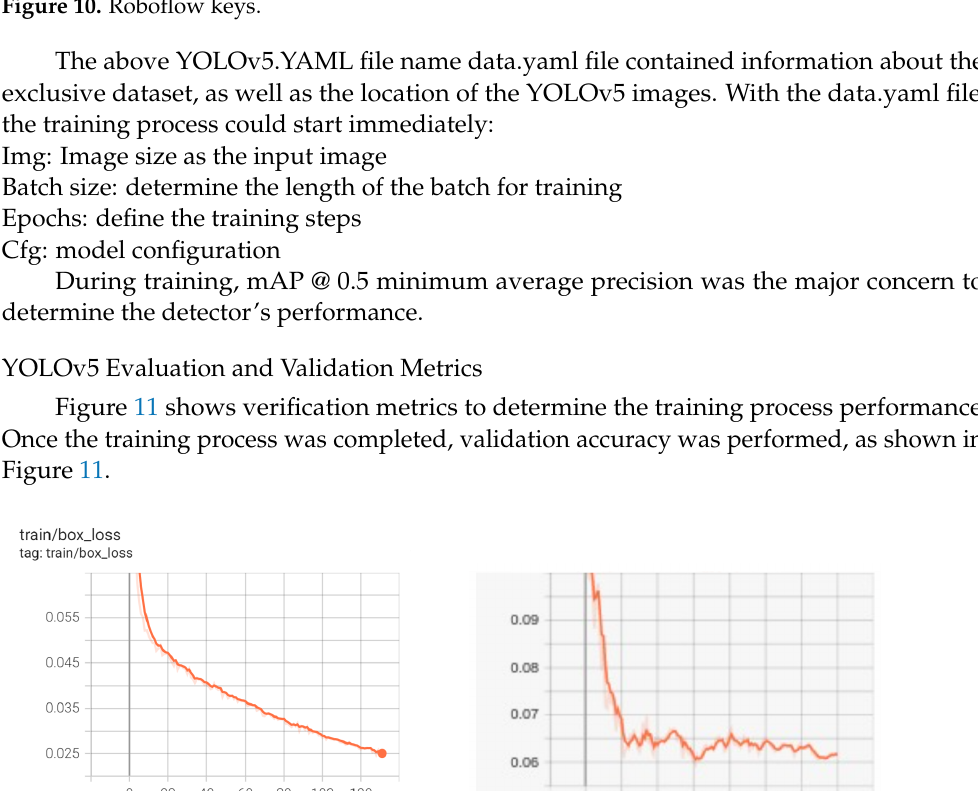
Figure 10. Roboflow keys.